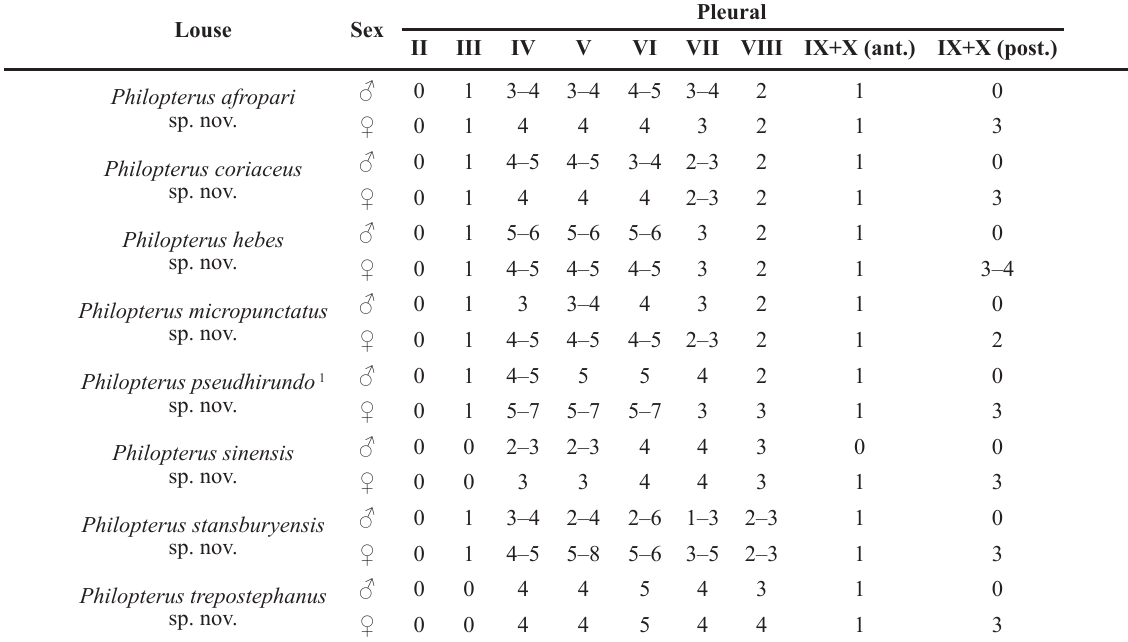
Table 4. Abdominal chaetotaxy of the species of Philopterus Nitzsch, 1818 described in this paper. Only pleural setae are listed here; for tergal setae, see Table 2; for sternal setae, see Table 3. Numbers denote the numbers of setae on one side of the abdomen only; for setal counts in the entire setal row of each segment, these numbers thus need to be doubled. Abbreviations: ant. = anterior end; post. = posterior